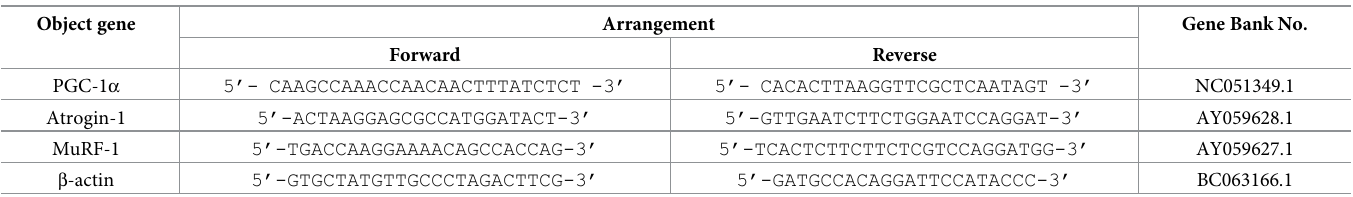
Table 1. Arrangement of synthetic gene-specific